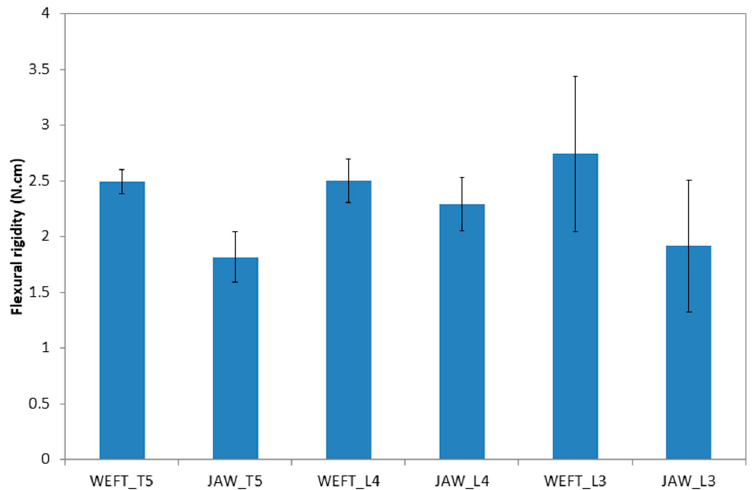
ff erent 3D warp interlock